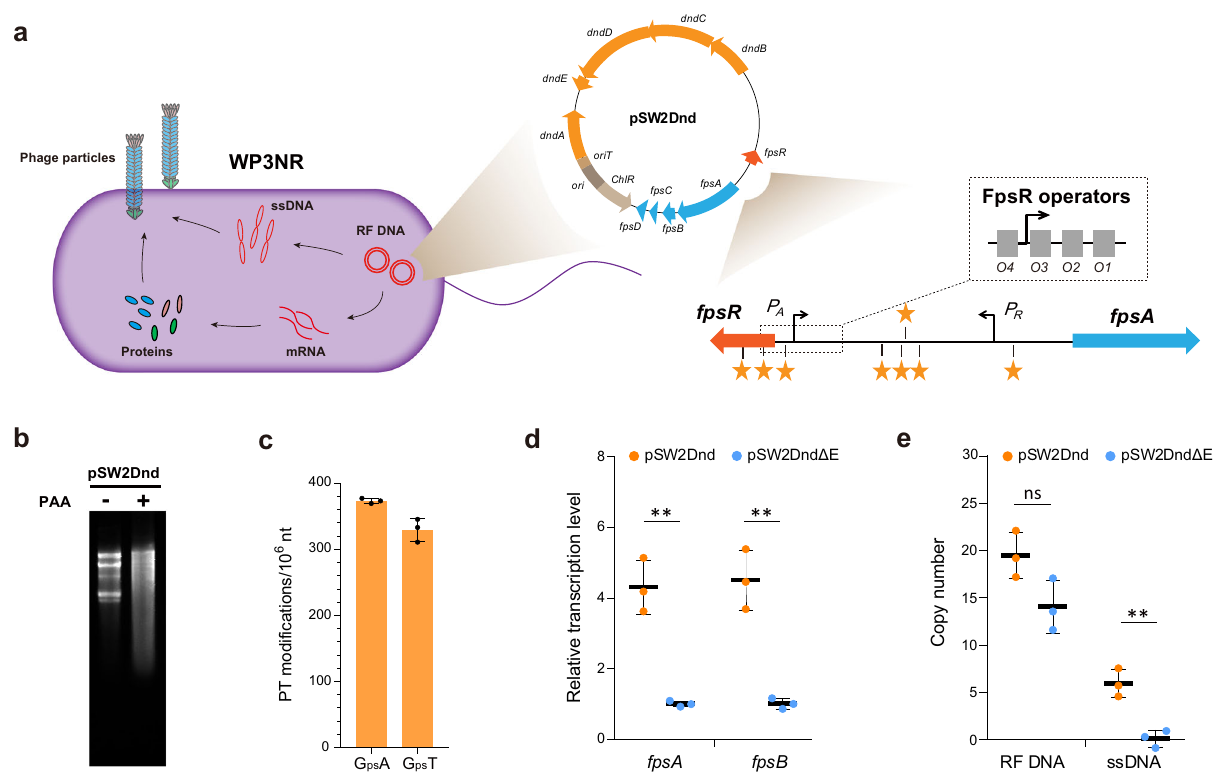
Fig. 4 PT modi fi cation in fl uences the gene transcription and DNA replication of phage SW1. a Schematic representation of the WP3NR- pSW2Dnd system for investigating the effect of PT modi fi cation. The double-stranded replicative forms of DNA (RF DNA), single-stranded DNA (ssDNA) and mRNA which were quanti fi ed via qPCR, are indicated in red. The promoters of fpsA ( P A ) and fpsR ( P R ) are responsible for the transcription of the SW1 structural genes fpsA-H and the regulator gene fpsR , respectively. The phage-encoded repressor FpsR binds to four operators located in P A and the intergenic region between fpsA and fpsR , thus functioning as the determinant of the genetic switch of SW1. The yellow stars indicate the putative PT modi fi cation sites. For clarity, the genes and regulatory elements are not drawn to scale. b Cleavage detection of PT modi fi cation in pSW2Dnd. Agarose gel showing the effect of treating pSW2Dnd from WP3NR/Dnd with PAA – TAE buffer. “ + ” and “ − ” represent treated and untreated plasmids, respectively. c Quanti fi cation of PT modi fi cations (G ps A and G ps T) in pSW2Dnd. The data represent the mean ± s.d. and are based on three biologically independent samples. d Relative transcription levels (RTLs) of SW1 genes in the WP3NR/Dnd and WP3NR/Dnd Δ E strains. e RF DNA and ssDNA copy numbers of pSW2Dnd and pSW2Dnd Δ E. Data are represented as mean ± s.d.. and based on three biologically independent samples. The signi fi cances were analyzed by two-sided unpaired Student ’ s t test. Speci fi cally, P = 0.0017 ( ∗∗ ) for fpsA and P = 0.0022 ( ∗∗ ) for fpsB of pSW2Dnd vs pSW2Dnd Δ E; P = 0.0643 (ns, not signi fi cant) for RF DNA and P = 0.0046 ( ∗∗ ) for ssDNA of pSW2Dnd vs pSW2Dnd Δ E. Source data are provided as a Source Data fi which PT modi fi cation affects phage gene expression, 8 PT modi fi cation motifs located within the fpsR-fpsA intergenic region were point mutated in pSW2Dnd and pSW2Dnd Δ E to generate two vectors: pSW2Dnd-IG and pSW2Dnd Δ E-IG (Supplementary Fig. S14). As expected, subsequent real-time qPCR (RT-qPCR) showed that there were no signi fi cant differences in the RTLs of SW1 genes and in the copy number of phage ssDNA after the PT modi fi cation motifs were mutated (Fig. 5a).